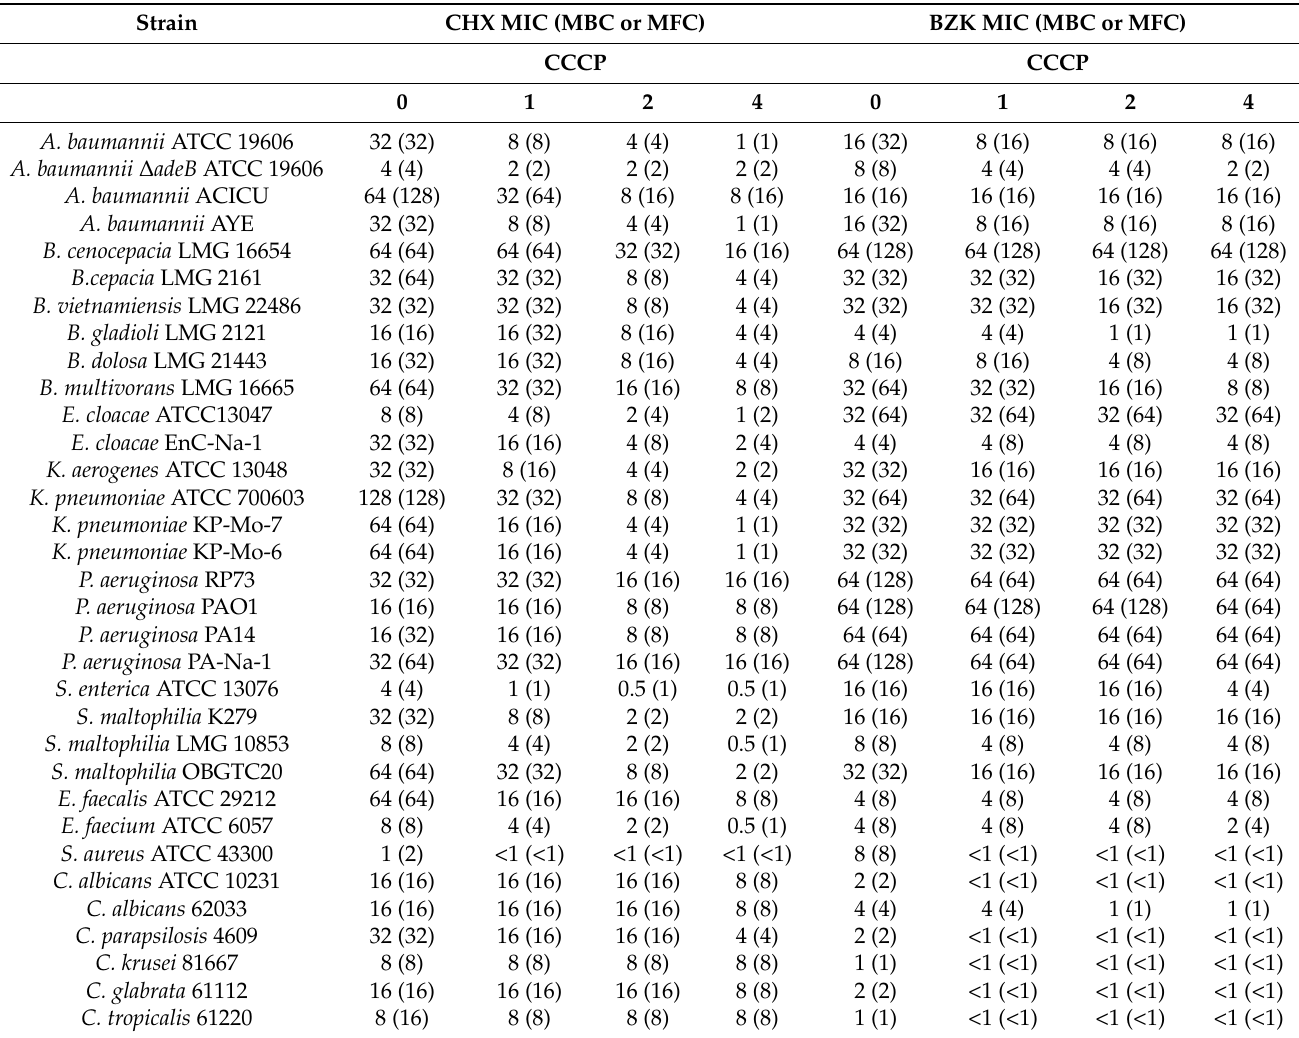
(Table 1). In addition, CCCP reduced the MIC and MBC (MFC in the case of Candida spp.) of BZK by one- to four-fold in A. baumannii , Candida spp., B. gladioli , B. dolosa , S. enterica and S. maltophilia strains, while it had no effect on the BZK MIC and MBC in other Burkholderia species, K. pneumoniae and P. aeruginosa strains (Table 1). In accordance with the previous data [19], the reduction in MIC and MBC of CHX and BZK due to CCCP was only four- and two-fold, respectively, in A. baumannii ATCC 19606 carrying the deletion of the adeB EP gene, consistent with the role of AdeB in CHX and BZK extrusion (Table 1). The data shown herein indicate that tolerance to CHX and BZK is mediated by activation of the EPs and are in agreement with previous publications showing that CHX and BZK tolerance in K. pneumoniae and A. baumannii clinical isolates is mediated by RND superfamily EP activation [13,16], and that CHX tolerance in P. aeruginosa clinical isolates is mediated by an increased expression of the mexA, mexC, mexE and mexX EP genes, and a decreased expression of the oprD gene [15]. Table 1. Effect of CCCP (mg/L) efflux pump inhibitor on CHX and BZK MIC (mg/L) and MBC (MFC in the case of Candida spp.) (mg/L) against Gram-negative bacteria, Gram-positive bacteria and yeasts. Strain CHX MIC (MBC or MFC) BZK MIC (MBC or MFC) CCCP CCCP 0